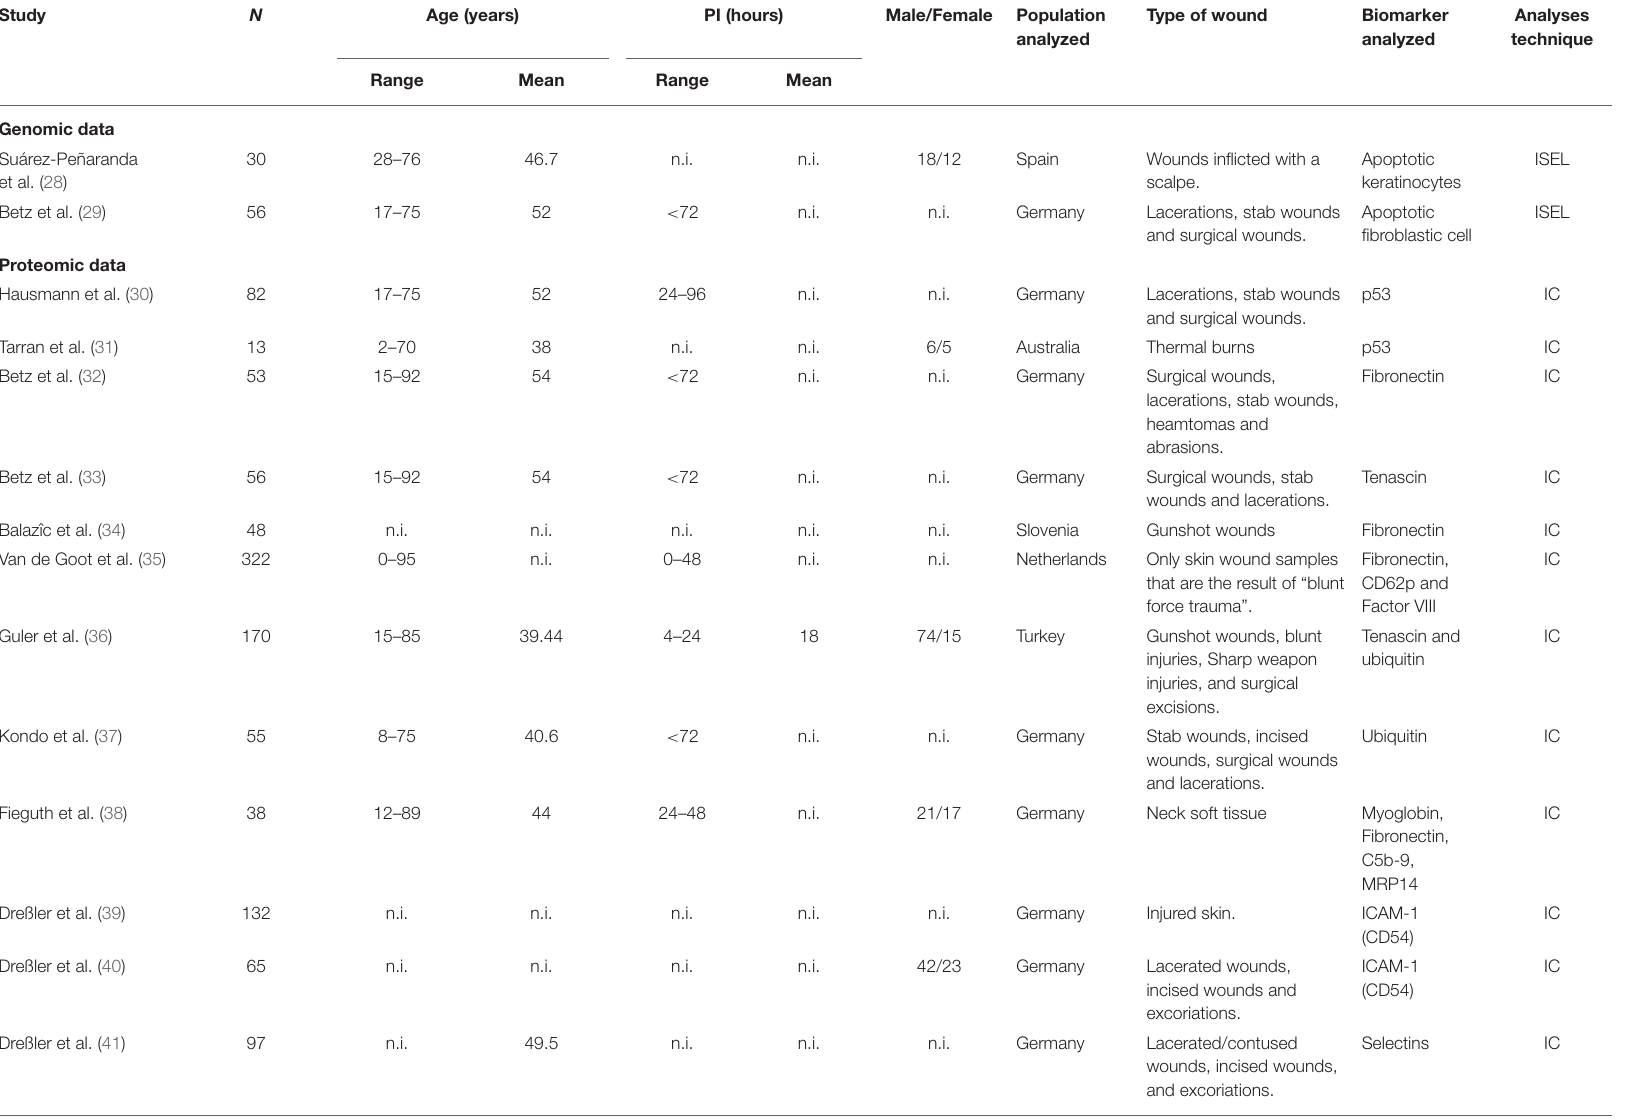
TABLE 3 | Age of wound in post-mortem studies a